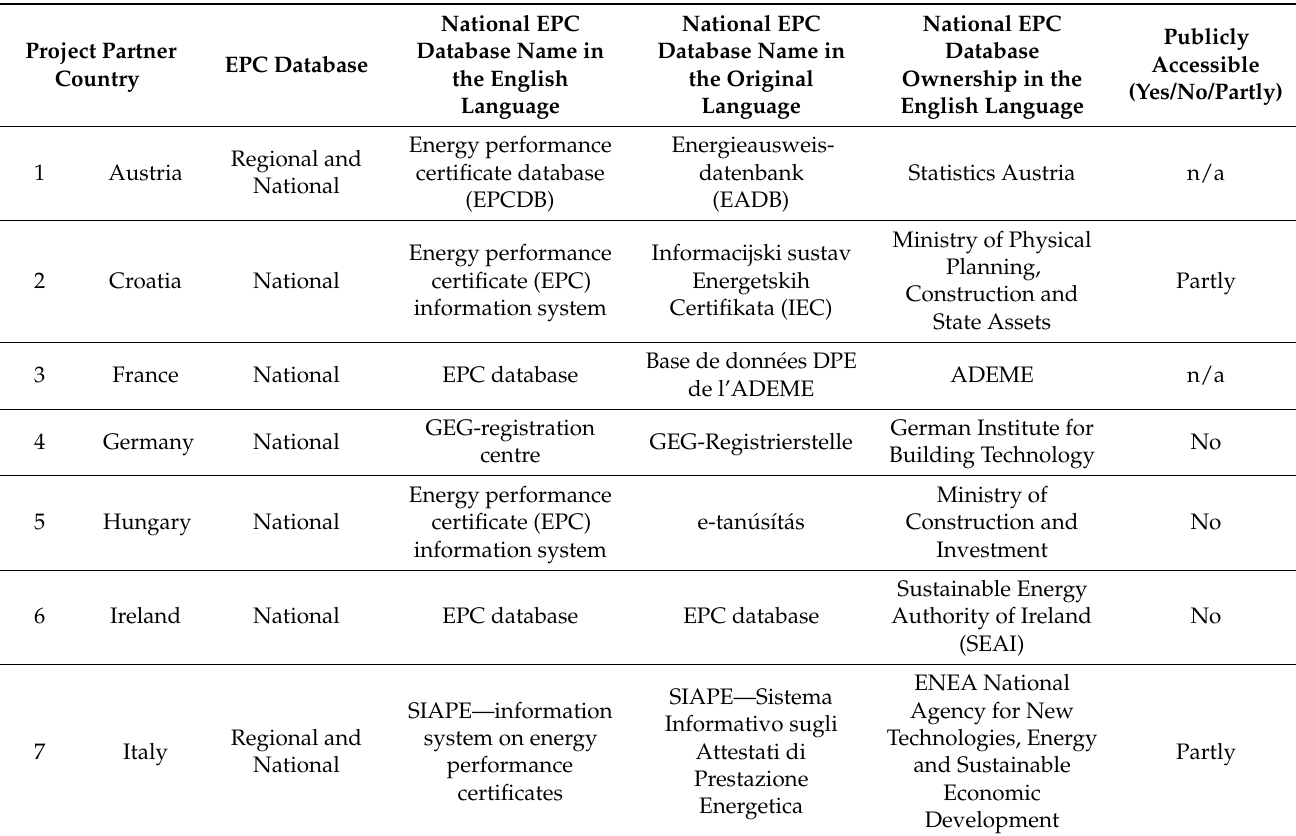
Table 4. Overview of national EPC databases in EU countries involved in the EUB SuperHub